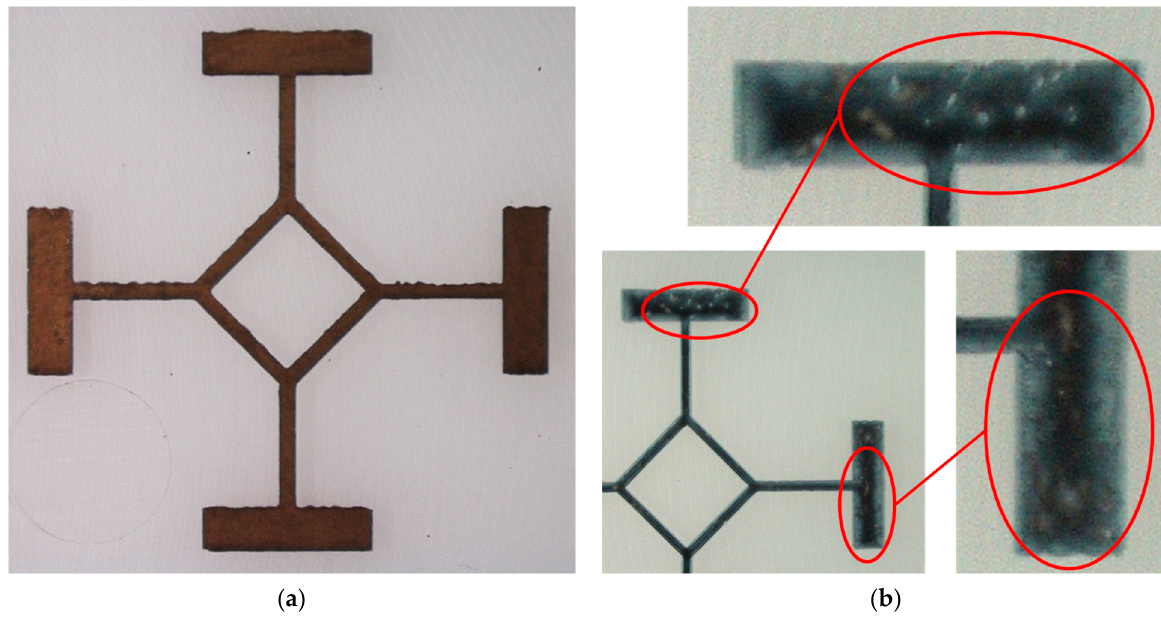
Figure 13. L3 probes for a substrate temperature of ( a ) 50 °C and ( b ) 60 °C. One possible solution to fill areas with less particles is the printing of multiple